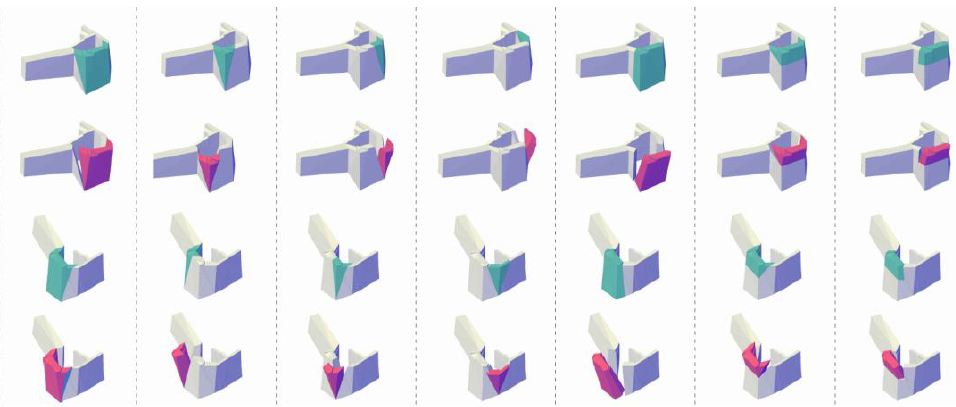
Figure 19. Three-dimensional representation of some of the kinematisms studied at the tower. Macro-elements involved in the kinematism are shown in the original position (green) and rotated position (red) for illustrative